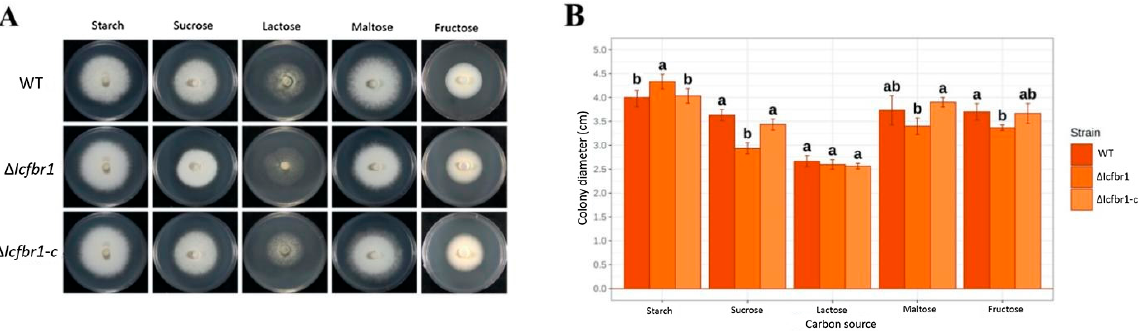
Figure 3. Colony morphology of wild type, ∆ Icfbr1, and ∆ Icfbr1-c were grown on minimal media (MM) with one type of carbon source. ( A ) Colony of wild type, ∆ Icfbr1 , and ∆ Icfbr1-c were grown on minimal media (MM) with starch, sucrose, lactose, maltose, and fructose, respectively, at 25 °C with a 12 h/12 h light/dark cycle for 10 days. ( B ) Colony diameter statistics for ( A ). The same letters in the same stress item indicate a nonsignificant difference estimated ( p ≤ 0.05). All tests were repeated at least twice with three replicates of each treatment.